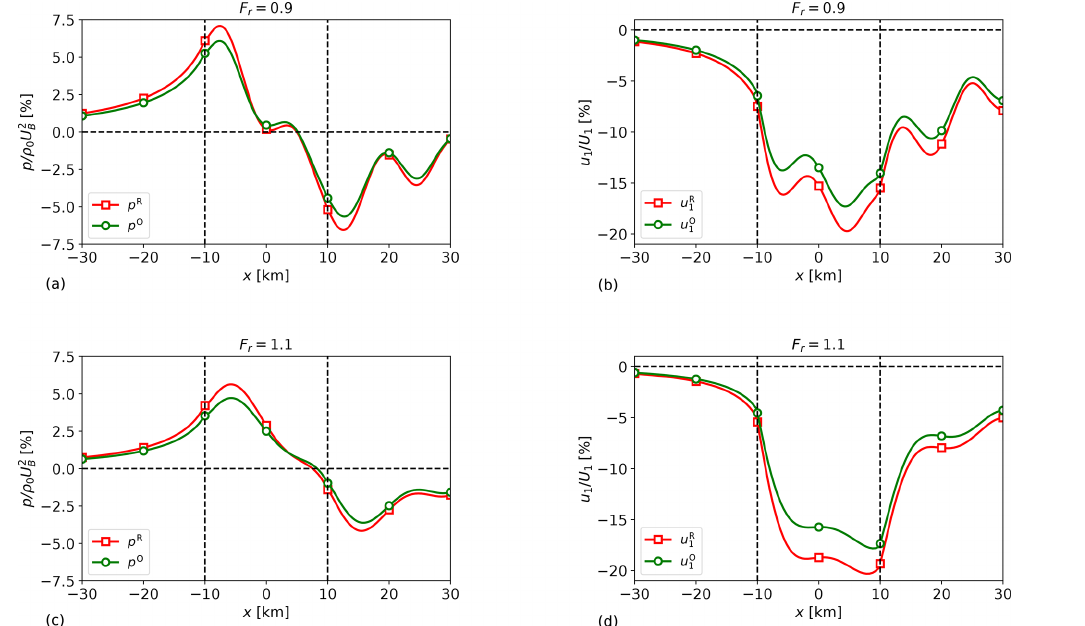
) and optimal ( u O ) 1 1